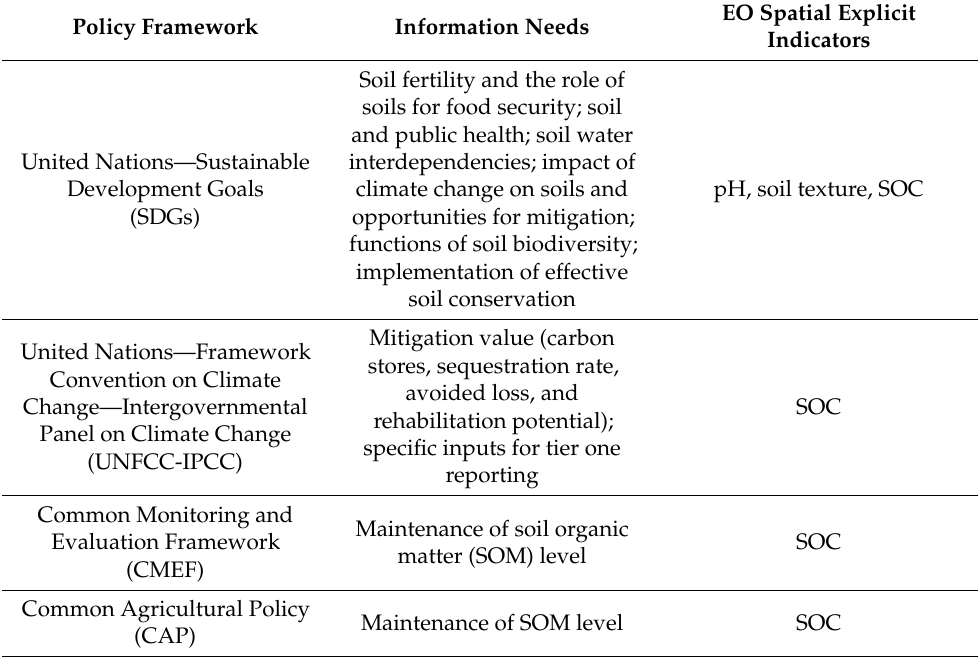
Table 1. The policy frameworks relevant to soil and information needs that can be supported by EO